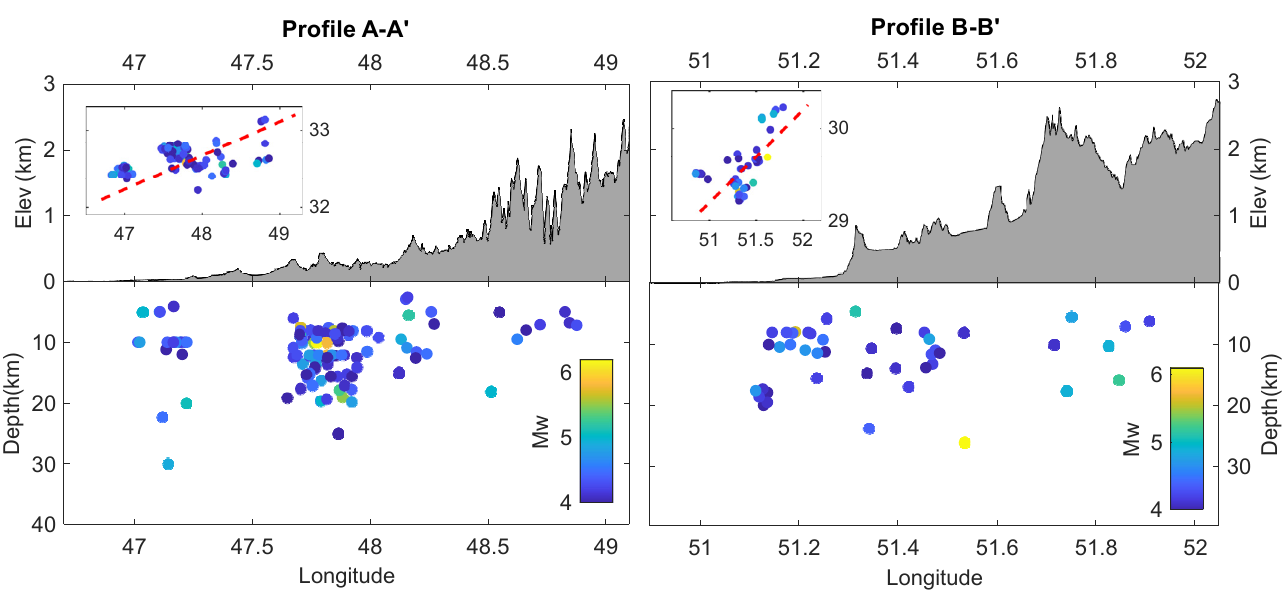
Figure 5. Cross-sections of Dezful Embayment displaying topography and seismicity in A-A’ and B-B’ sections shown in Figure 1. The color scale represents earthquake magnitudes. The high seismicity density in the area is restricted to below 5 km. The inset is an upper view of the cross-section profile (red dash line) and its nearby seismicity shown in Figure 1. Details of each earthquake are provided in Yaghoubi (2020). Table 3. Stress inversion results at different locations in the Dezful